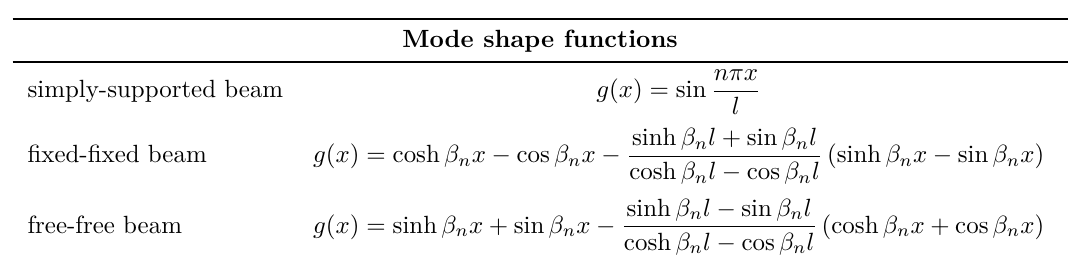
Table 2. The overview of the n -th mode shape functions for the coordinate x ∈ h 0 , l i for a simply-supported, fixed-fixed, and free-free beam. (The products of the wavenumbers and the beam length β n l for the first three modes are β 1 l = 4 . 7300, β 2 l = 7 . 8532, and β 3 l = 10 . 996.)